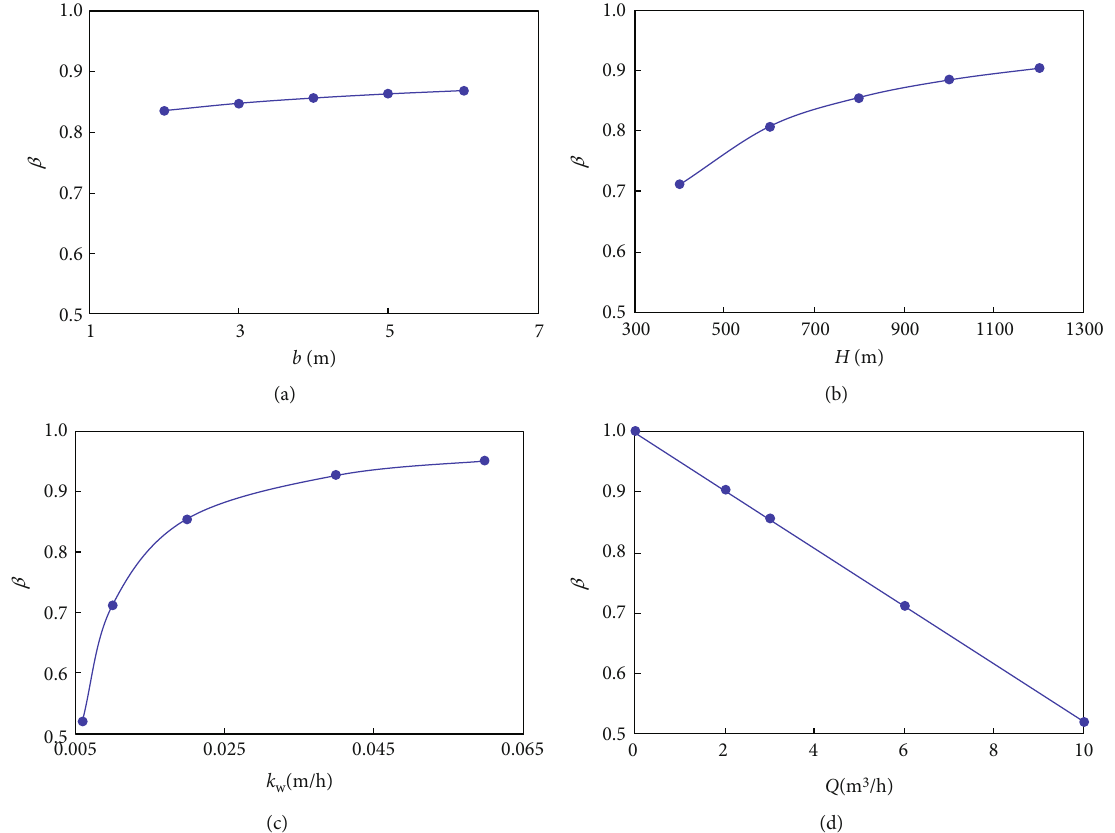
Figure 3: Variation of the water pressure reduction coe ffi cient of the shaft lining: (a) outer diameter of shaft; (b) depth of shaft; (c) permeability of con fi ned rock; (d) seepage fl